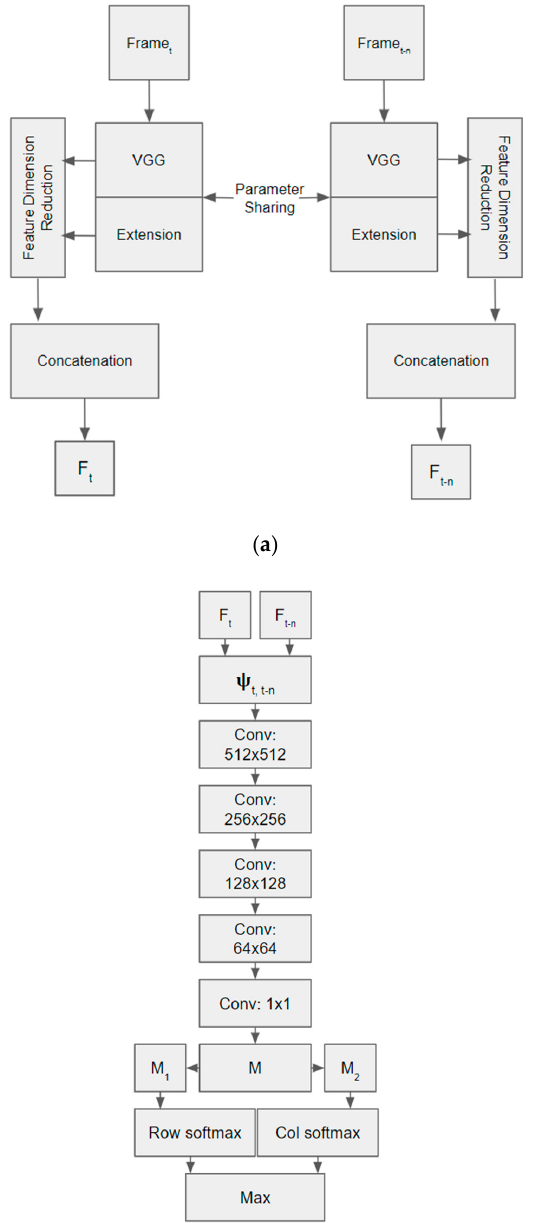
Figure 2. Deep Affinity Network (DAN) architecture [16]: ( a ) Stage 1 of DAN; ( b ) Stage 2 of DAN. VGG stands for Visual Geometry Group.